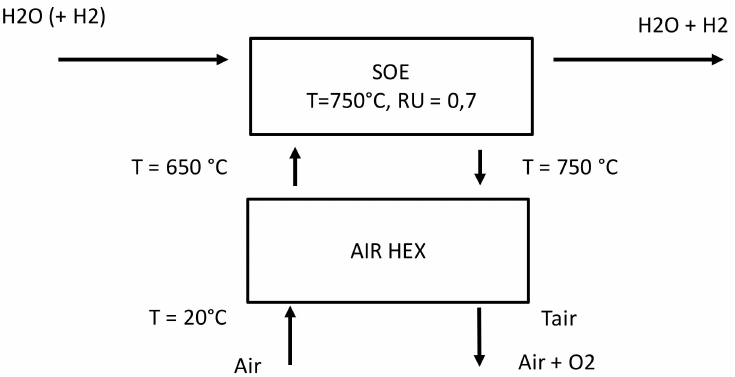
Figure 4. Scheme of the hotbox studied in the